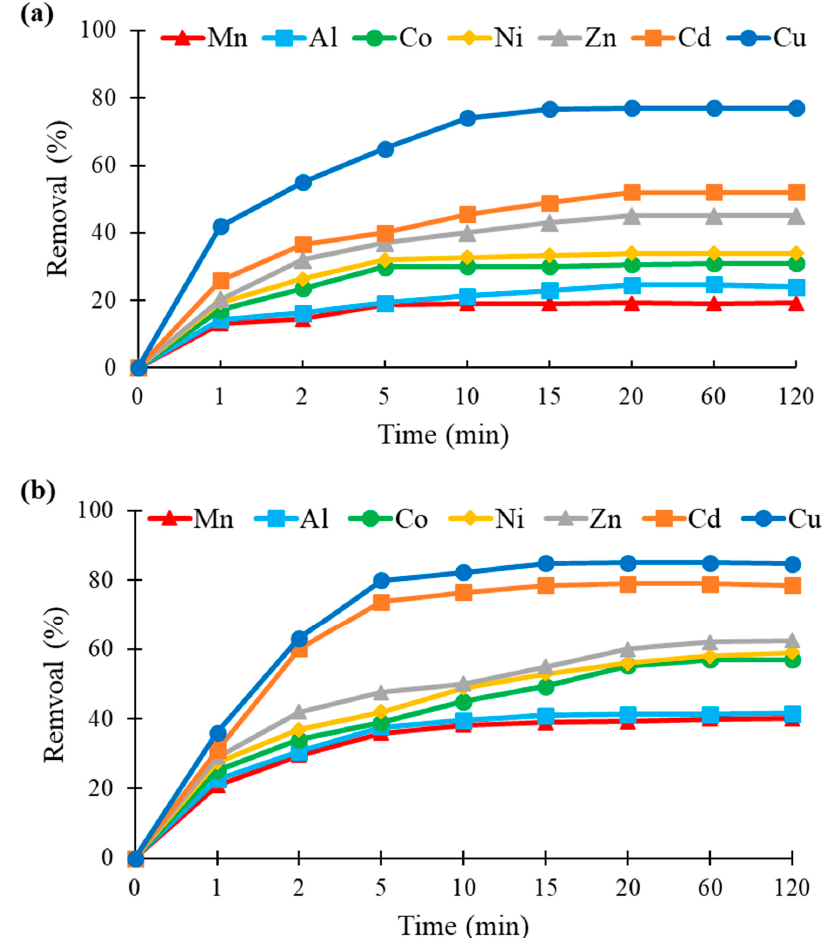
Figure 5. Kinetics of metal removal (in %) by ( a ) hemp- and ( b ) flax-based felts at an initial concen- tration of 25 mg/L (other conditions: 1 g of felt in 100 mL of solution; agitation speed, 250 rpm; temperature, 22 ± 1°C; n = 3).